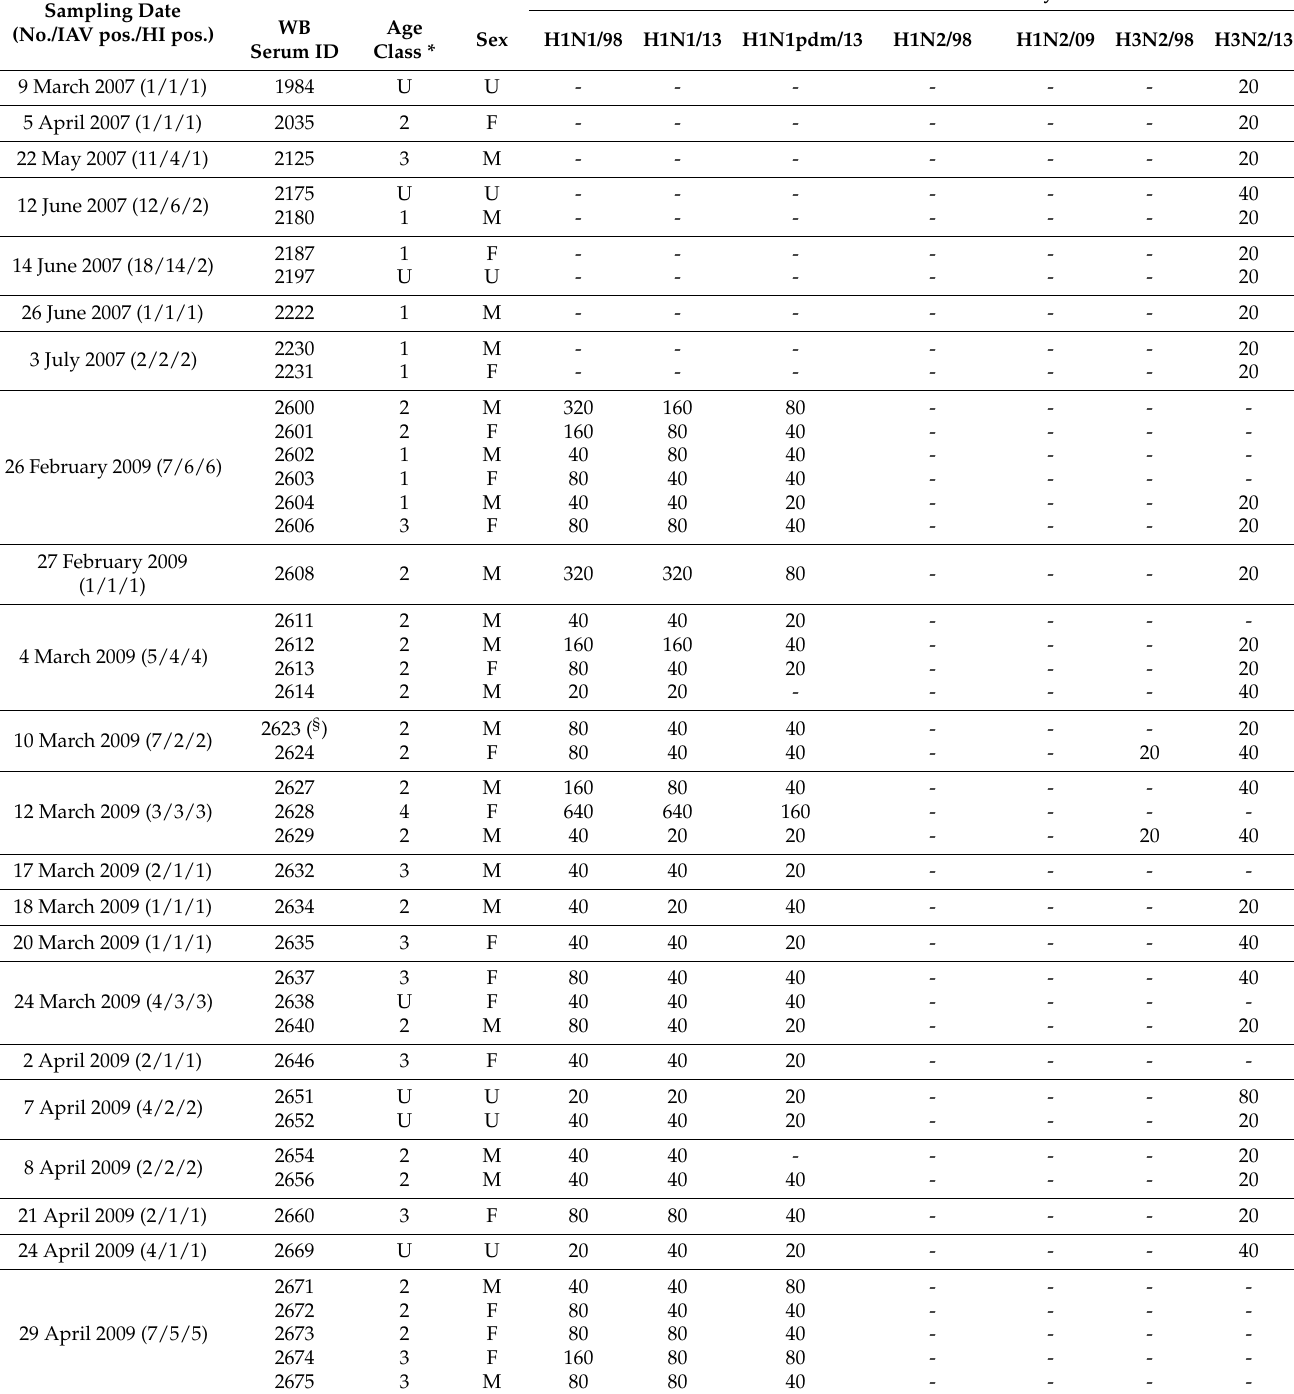
Table 2. Hemagglutination inhibition assay (HI) reciprocal titers obtained from 141 available wild boar (WB) that had sera tested positive for influenza A virus nucleoprotein (NP) by NP-ELISA (Northern Italy, 2007–2014). The HI assays were performed using the following strains of in- activated influenza A viruses (IAV): H1N1/98, A/swine/Italy/1513/1998/H1N1av; H1N1/13, A/swine/Italy/311368/2013/H1N1av; H1N1pdm/13, A/swine/Italy/282866/2013/H1N1pdm; H1N2/98, A/swine/Italy/1521/1998/H1huN2; H1N2/2009, A/swine/Italy/284922/2009/H1huN2; H3N2/98, A/swine/Italy/1523/1998/H3N2; and H3N2/13,